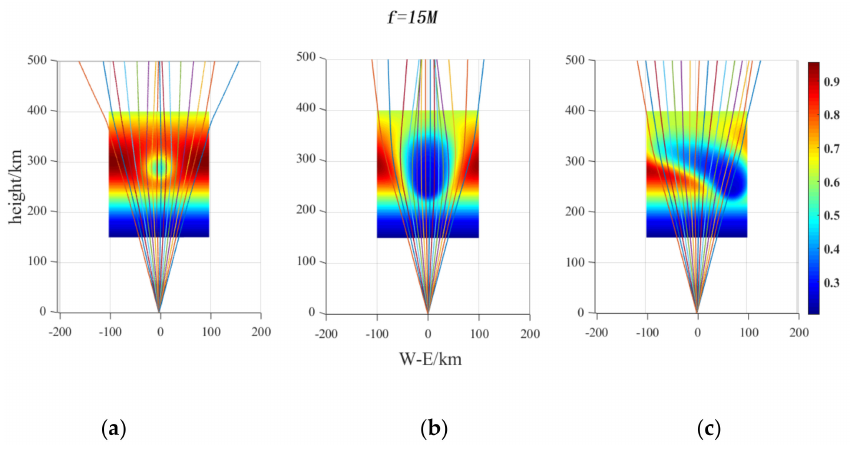
Figure 6. 3D ray-tracing simulation of 15 MHz short wave propagation path after 100 s of H 2 released by rocket under different flight paths (electron density unit: 10 6 cm − 3 ): ( a ) 300 km fixed − point release ( b ) 250 − 350 km vertical path ( c ) 250 − 350 km parabolic